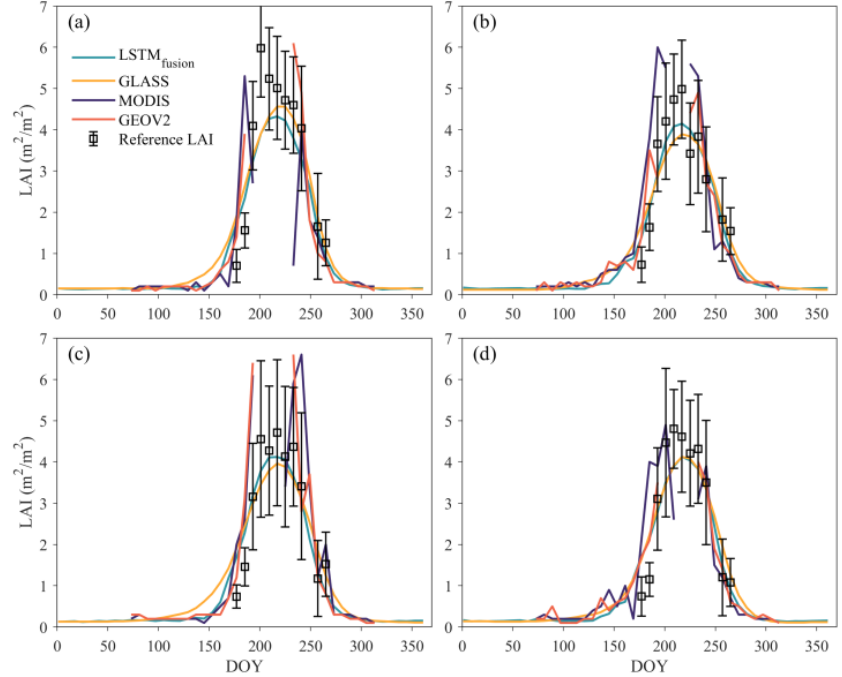
Figure 8. Temporal variations in the LSTM fusion ( a ), MODIS ( b ), GLASS ( c ), VIIRS ( d ), and reference LAIs. The error bar of the reference LAI stands for mean ± one standard deviation.